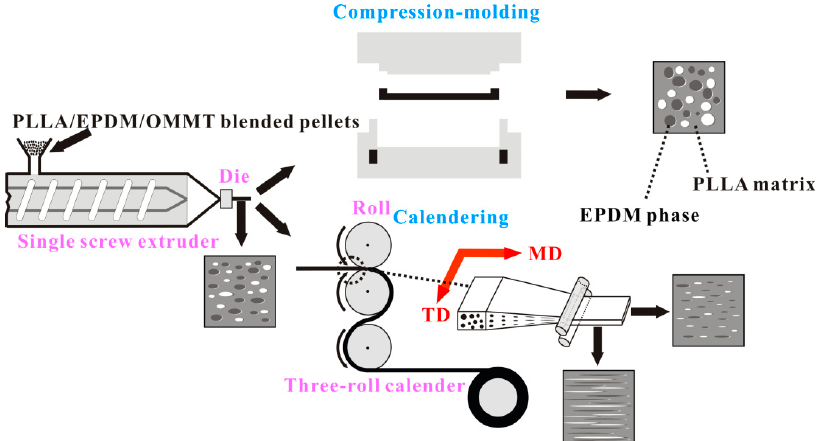
Figure 4. Comparison of morphology between PLLA/EPDM/OMMT samples prepared by compression-molding and calendering.